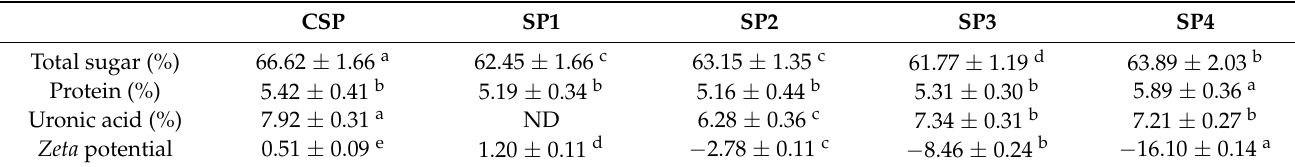
Table 1. The chemical compositions and zeta potentials of SPs.